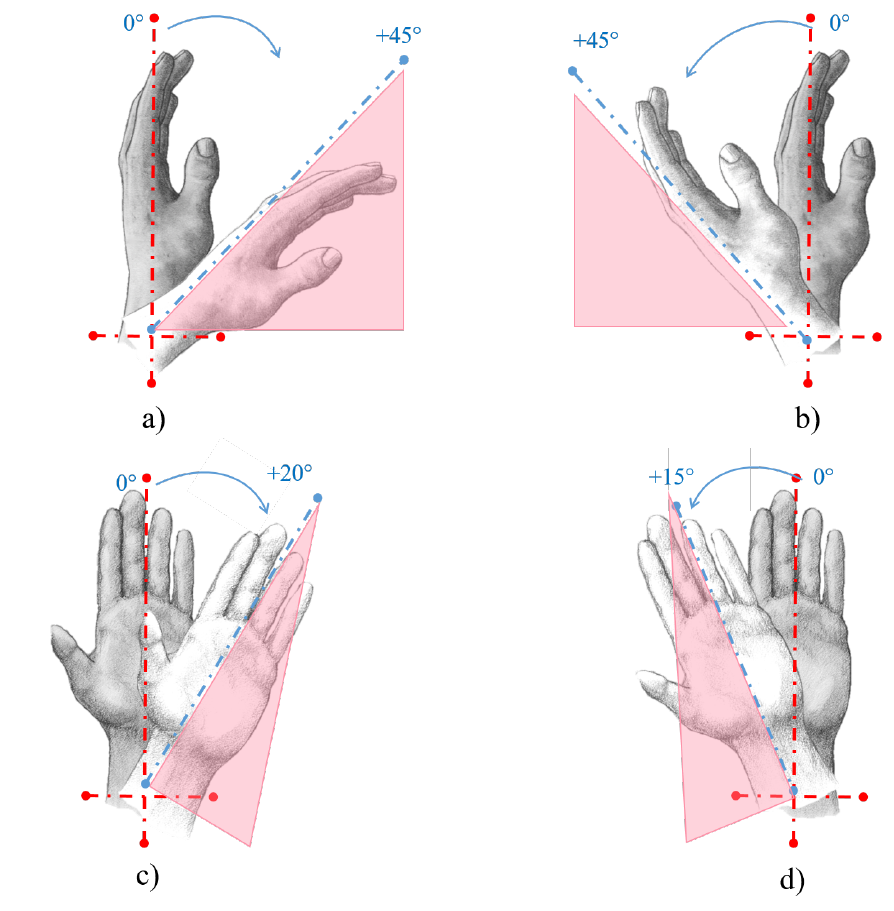
Figure 16. Awkward wrist postures according to ISO 11226, for a static posture, and 11228-3, while performing dynamic and repetitive movements. ( a ) Wrist palmar flexion awkward posture > 45°; ( b ) wrist dorsal extension awkward posture > 45°; ( c ) wrist ulnar deviation awkward posture > 20°; ( d ) Wrist radial deviation awkward posture >